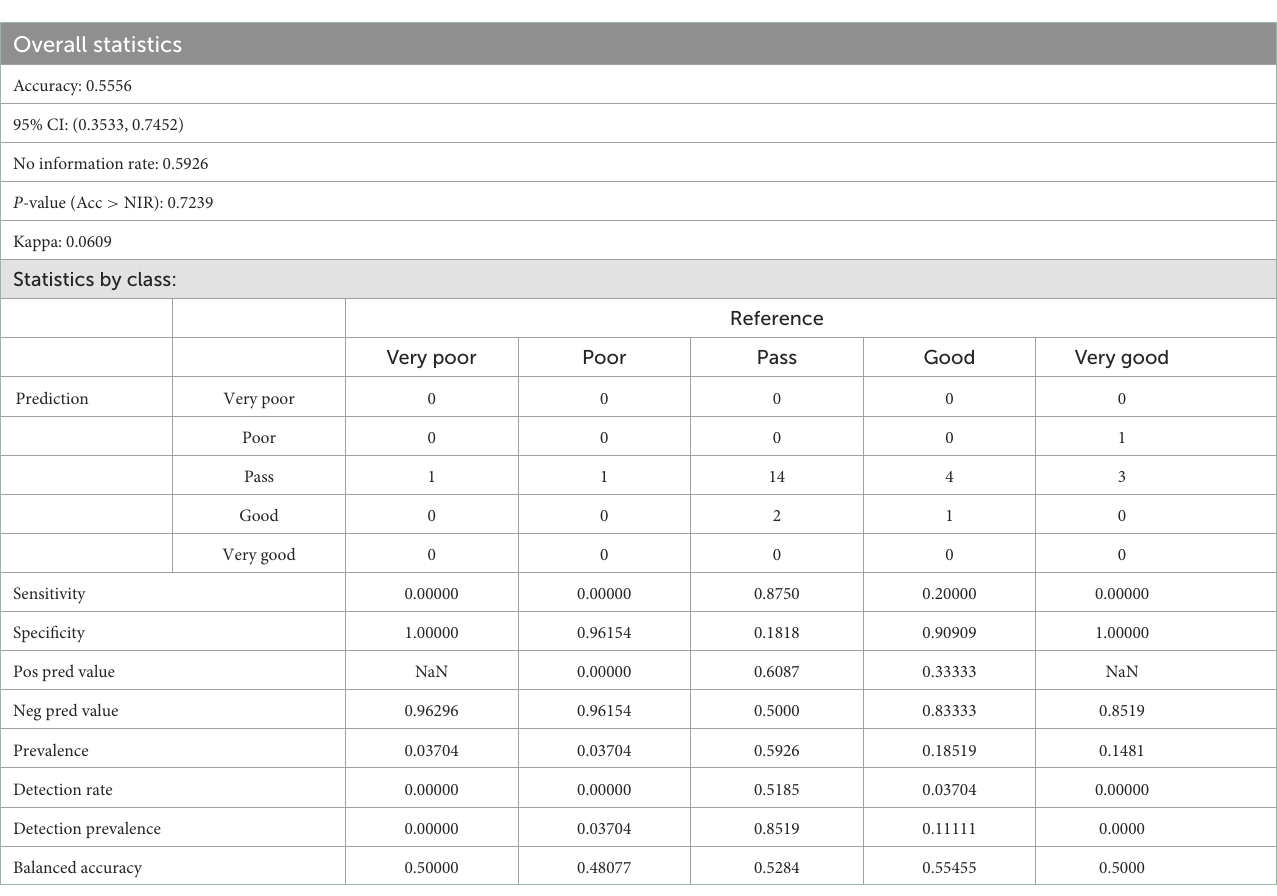
TABLE 5 Results of confusion matrix of the best KNN